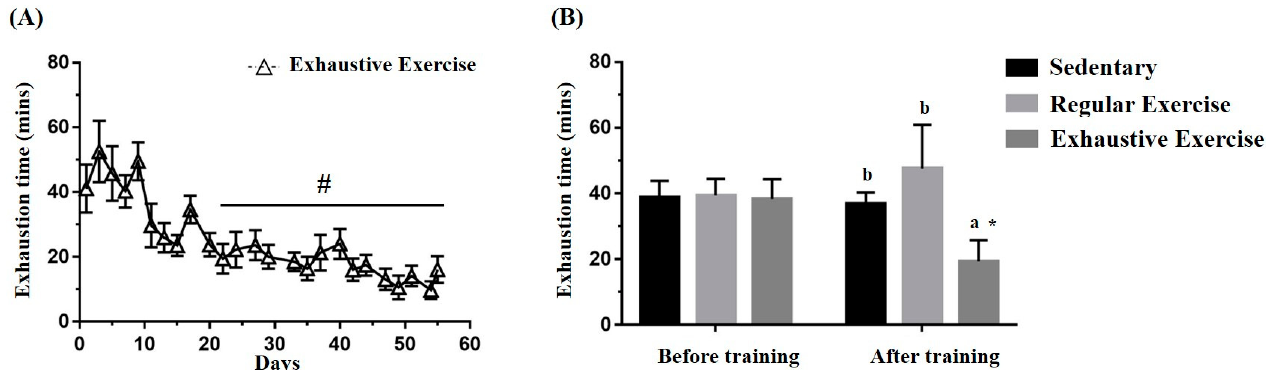
Figure 3. Effects of the eight-week training intervention on endurance performance. ( A ) The endurance capacity profile in the exhaustive exercise group throughout the study period. ( B ) The endurance capacities in all groups before and after the study. The data are mean ± standard deviation. Columns with different letters (a, b) are significantly different at p < 0.05 between groups by using one-way ANOVA. * p < 0.05 within the group and # p < 0.05 compared with day 1 exercise capacity by paired t test.